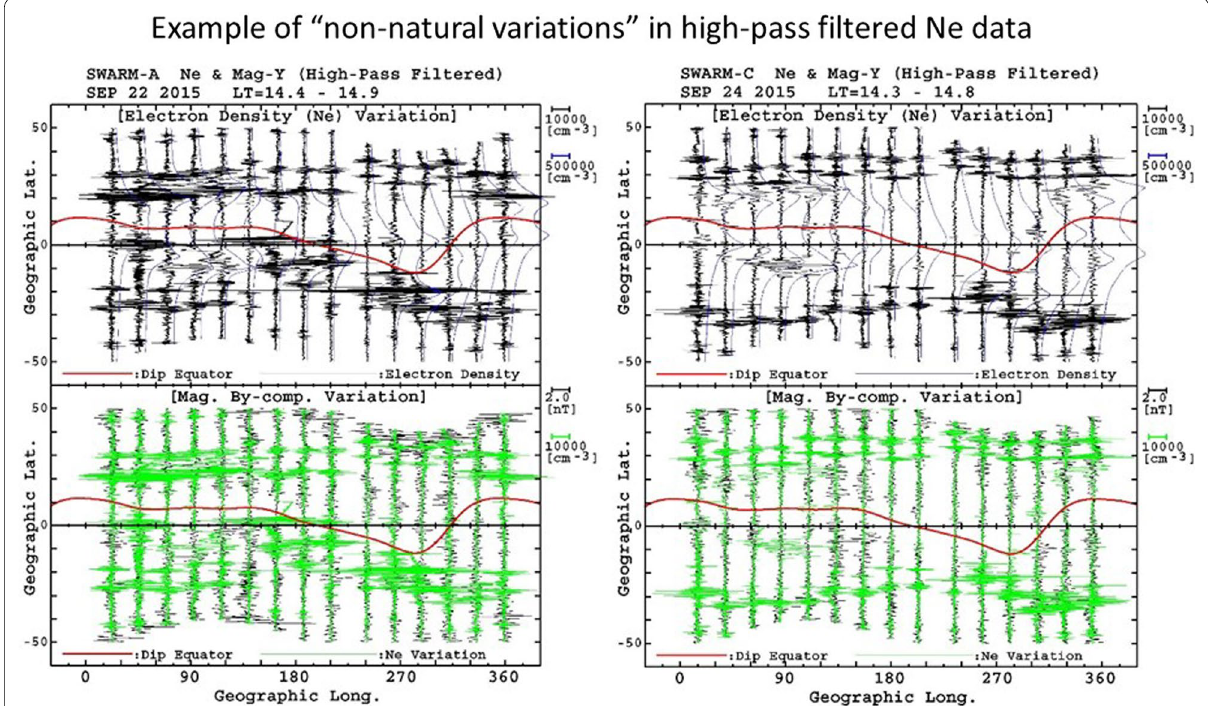
Fig. 12 A typical example of "non-natural" variations appeared on Sep. 22 (Swarm-A) and Sep. 24 (Swarm-C). The appearance is similar for SW-A and SW-C but 2 days shifted for SW-C. The upper panels show the Ne and δNe, and the lower panels show the magnetic ripples (black line) and δNe (green line). Geographic latitude and longitude are